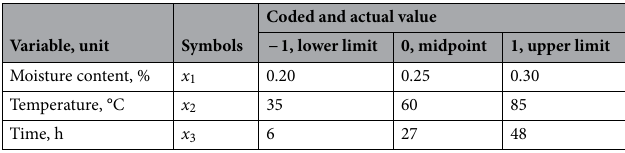
Table 2. Coded and actual levels of the process variables for the Box–Behnken